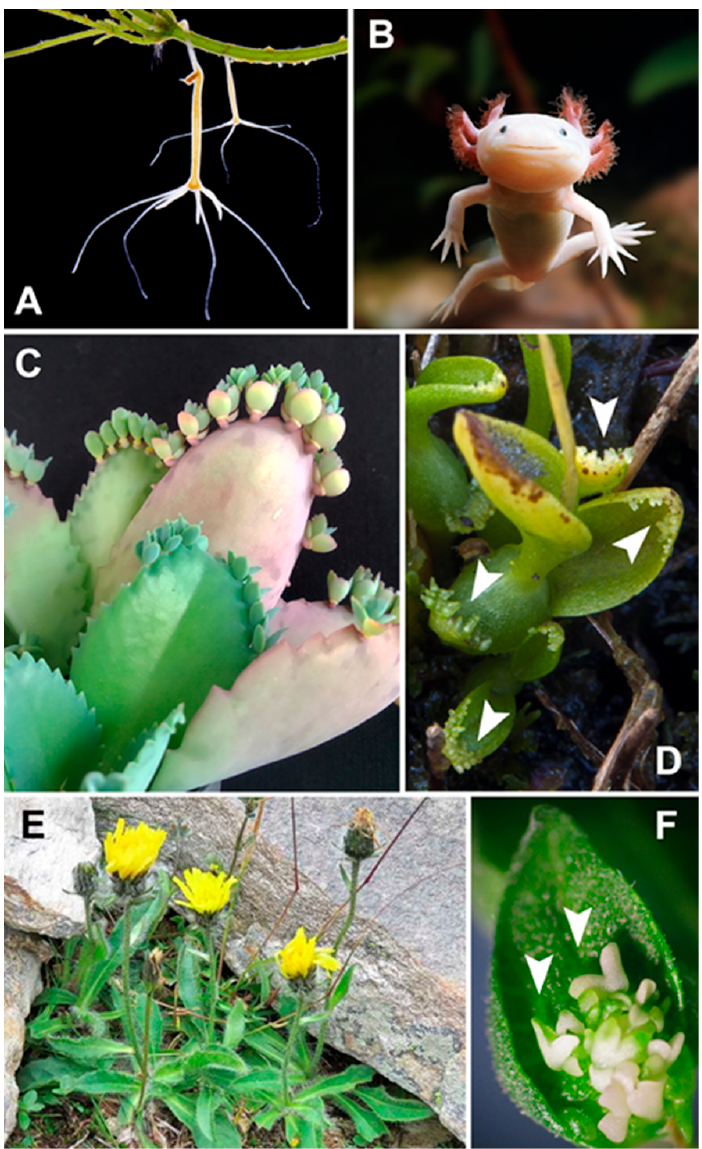
Figure 1. Animals able to regenerate lost body organs in vivo: ( A ) Hydra vulgare , an aquatic invertebrate (©Warren Photographic, www.warrenphotographic.co.uk/05836-common-hydra-budding; accessed on 11 October 2022). ( B ) Mexican axolotl ( Ambystoma mexicanum ), an aquatic salamander (©Warren Photographic, www.warrenphotographic.co.uk/00108-albino-axolotl; accessed on 11 October 2022). Examples of plants with natural epiphylly: ( C ) Kalanchoe laetivirens . ( D ) Malaxis paludosa (Michael Dodd’s photo, Open University, Milton Keynes, UK). The white arrowheads indicate the propagules. ( E ) Hieracium alpinum , a species of Asteraceae with an apomictic triploid cytotype in vivo (Mauro Felicioli’s photo, www.actaplantarum.org/flora/flora_info.php?id=506593; accessed on 11 October 2022). ( F ) An unusual example of a plant with epiphyllous embryos induced in vitro: the interspecific hybrid EMB-2 ( Helianthus annuus x H. tuberosus ). The white arrowheads indicate the somatic embryos.